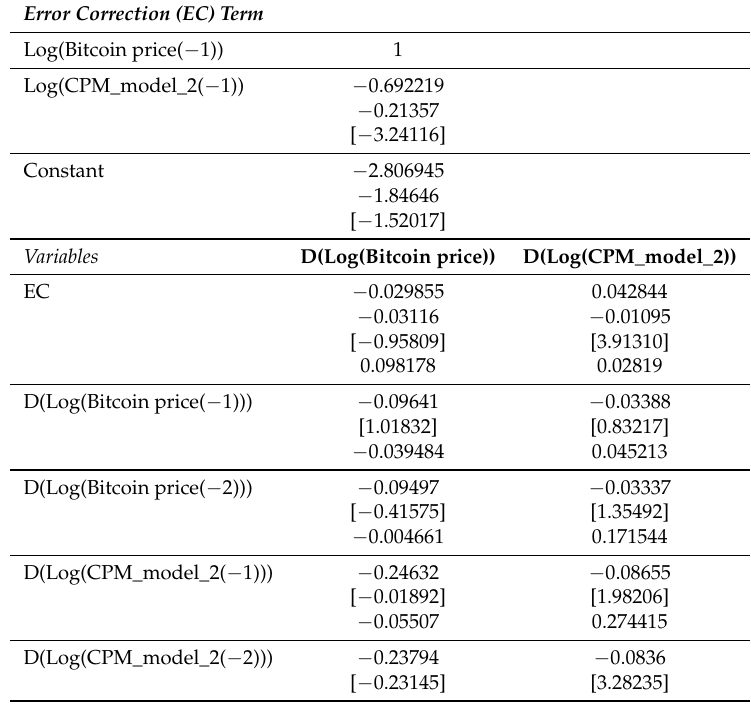
Table A5. VECM(2) for the variables Log(Bitcoin price) and Log(CPM model 2). Second sample: